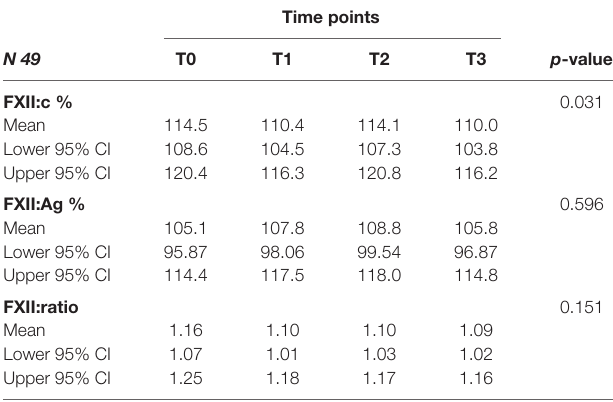
TaBle 3 | FXII activity, antigen, and ratio in multiple sclerosis patients over four time